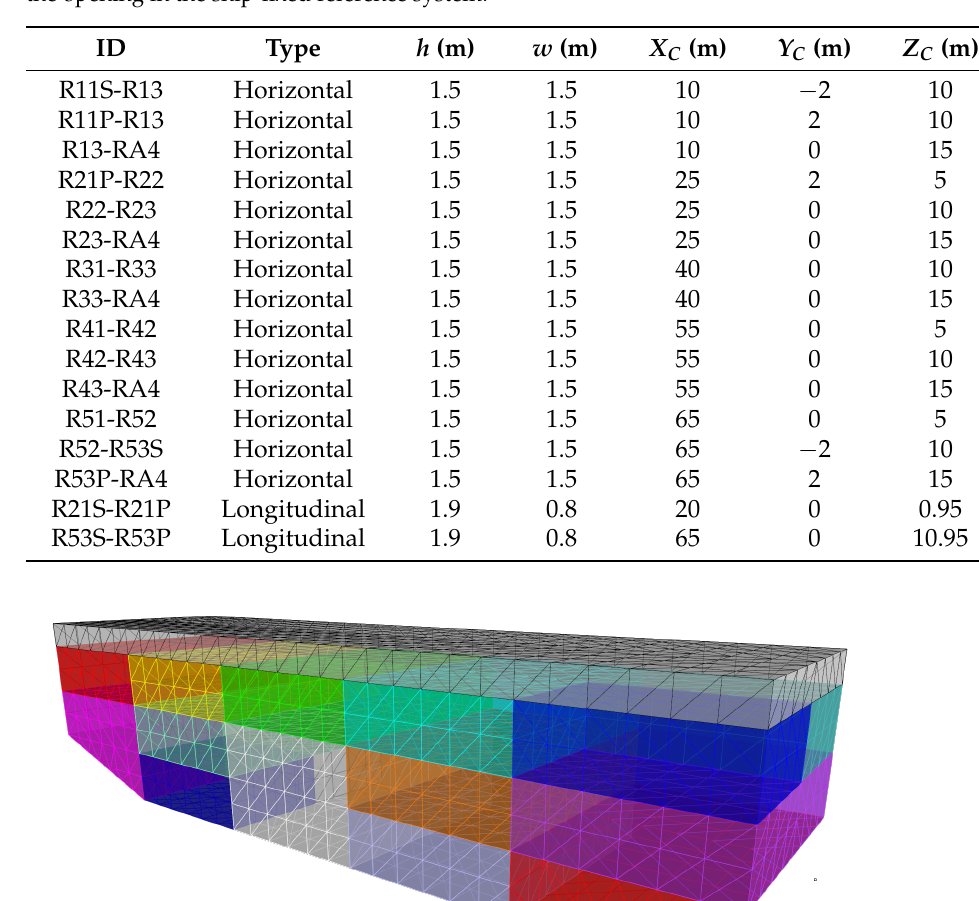
Table 2. Main characteristics of the test geometry openings. C = ( X C , Y C , Z C ) is the center of the opening in the ship-fixed reference system.